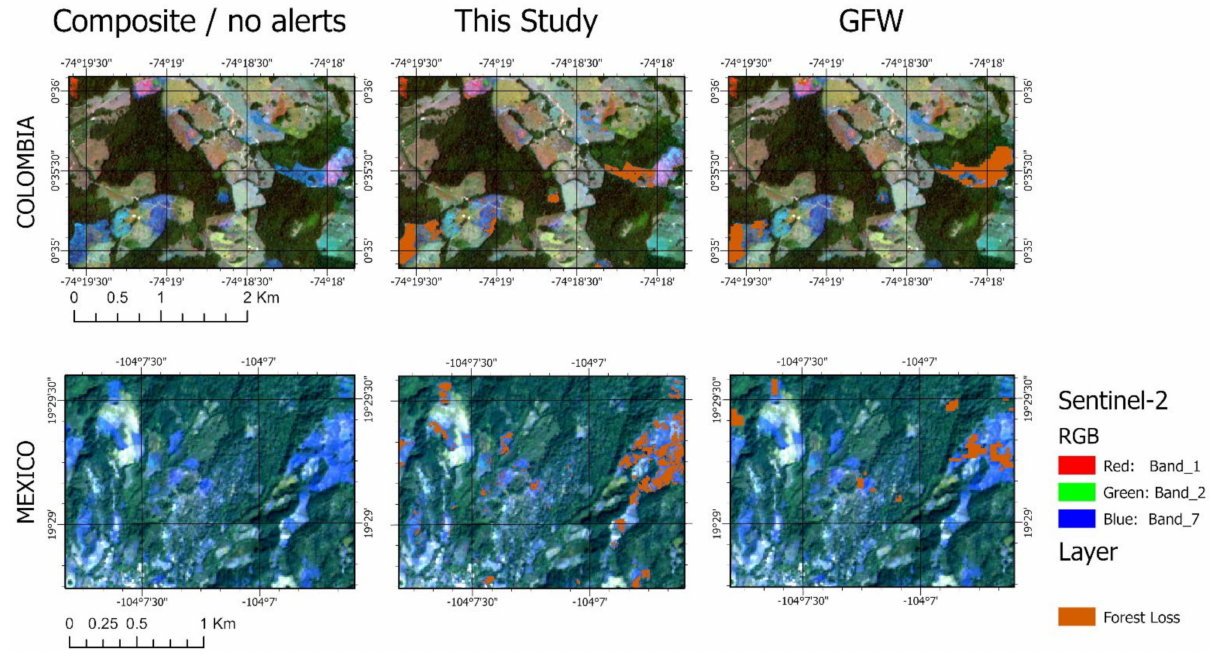
Figure 6. A comparison of PYEO deforestation alerts to Global Forest Watch over two small areas in Colombia and Mexico, showing a color composite of Sentinel-2 data used for the automated change detection in this example from January to December 2018. The color composite has the combination of the earliest acquisition date and the date of change detection. In the Sentinel-2 RGB composite image, red corresponds to the blue channel of the earliest date, green corresponds to the green channel of the latest date and blue corresponds to the red channel of the latest date. On the maps to the left, dark blue corresponds to forest cover loss, while in the center and to the right, forest cover loss detections are overlaid in orange. GFW: Global Forest